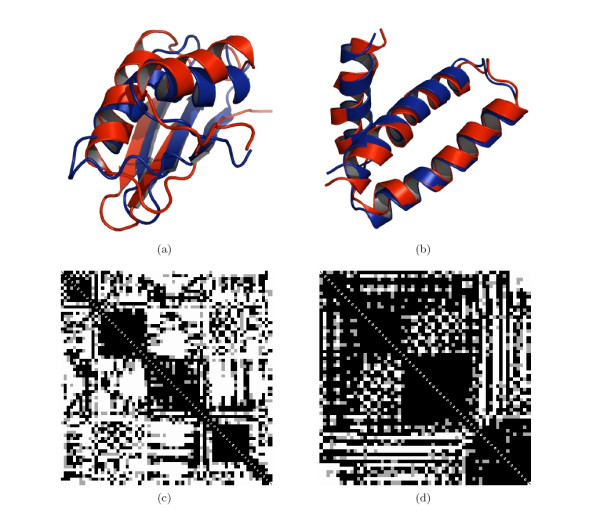
Top Row: Overlay of some predicted structures. The overlay of the predicted (red) and experimental conformation (green) documents the close agreement of conformations for 1orc[66] and 1ail[67]; only the backbone of the proteins is shown for clarity (generated with PYMOL [62]). Bottom row:  Cβ-Cβ distance difference matrices: A pixel in row i and column j of the color coded distance map indicates the difference in the Cβ-Cβ distances of the native and the folded structure. Black (gray) squares indicate that the Cβ-Cβ distances of the native and the other structure differ by less than 1.5 (2.25)Å respectively. White squares indicate larger deviations. The data indicates clearly the presence of all short-range and long-range native contacts for the high-quality decoys and good agreement even for the predictions from low-quality decoy sets.